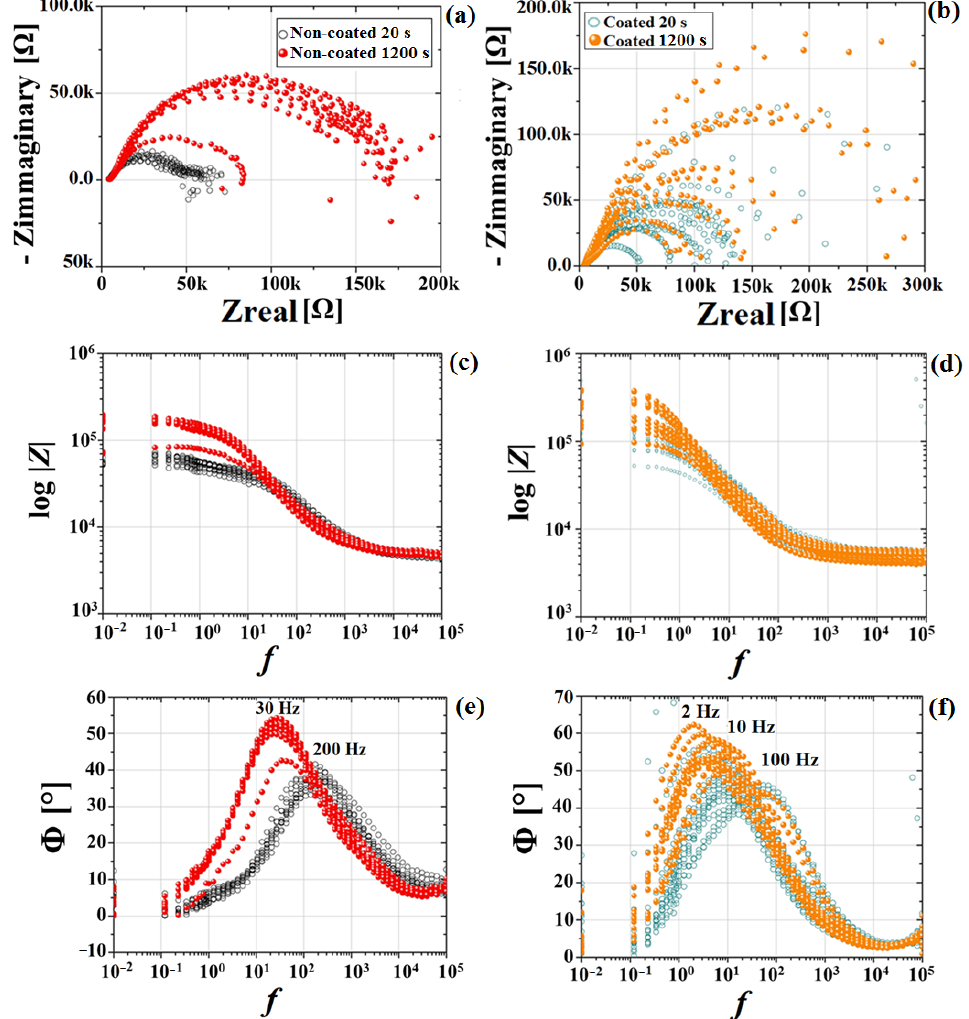
Figure 9. EIS spectra obtained for non-coated (left) and coated (right) samples at the start (20 s) and after 1200 s exposure to the electrolyte. Nyquist plot ( a , b ); Bode modulus ( c , d ); Bode phase ( e , f ).